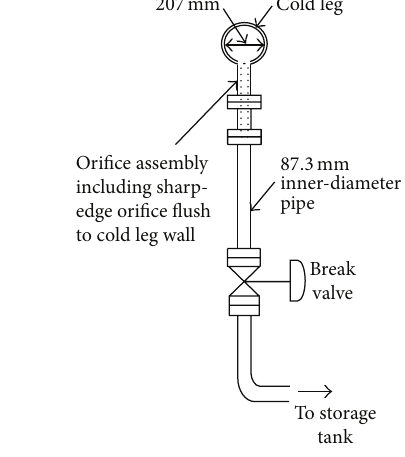
Figure 3: Schematic view of LSTF break unit. Table 2: Major test conditions in each LSTF